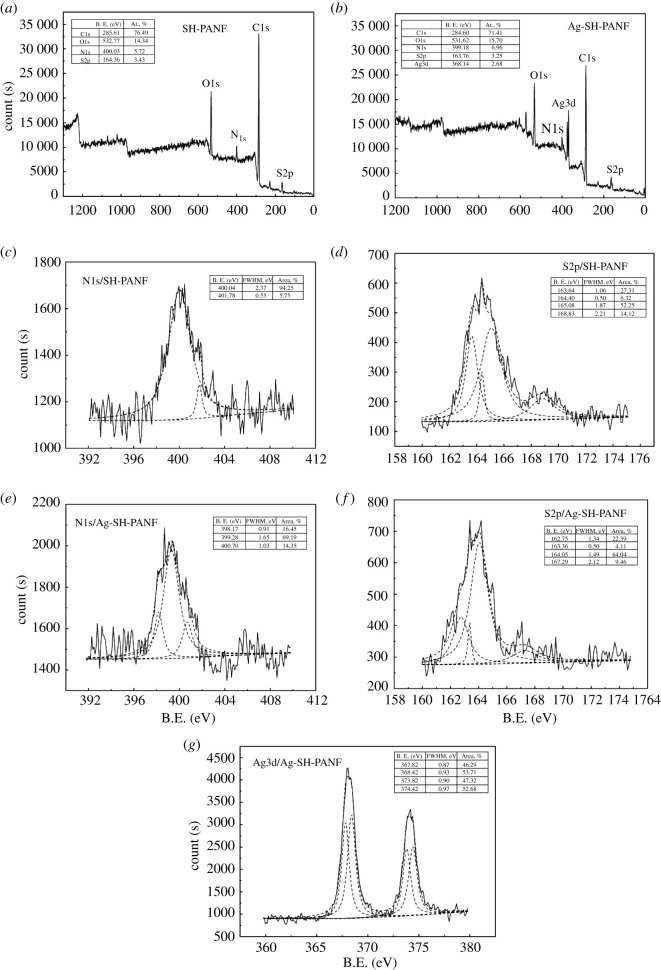
XPS survey scans and high-resolution scans of the N1s, S2p and Ag3d peaks for the fibres.